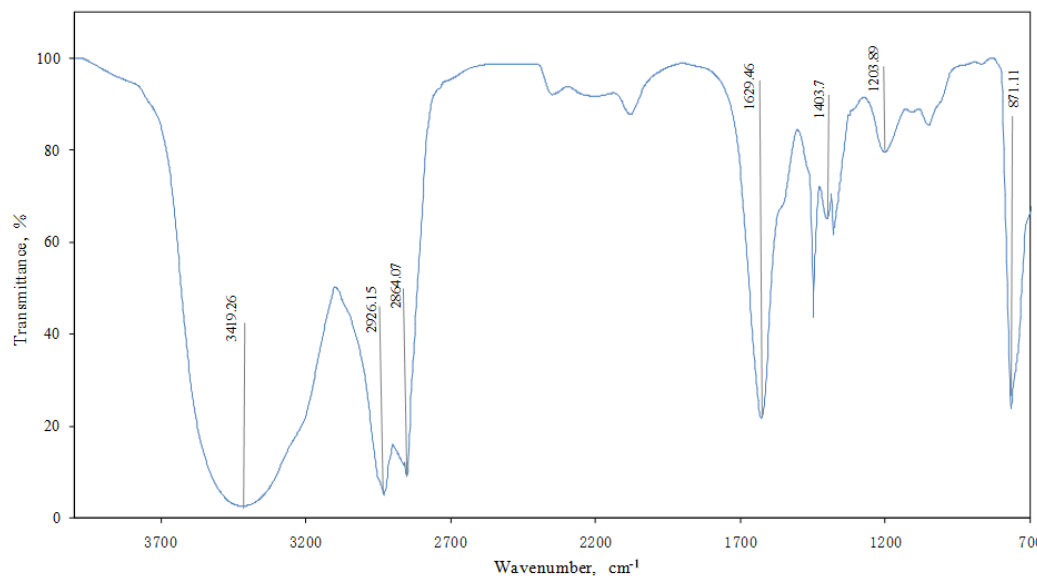
Figure 5. FT-IR Analysis of New Naphthol Gels.